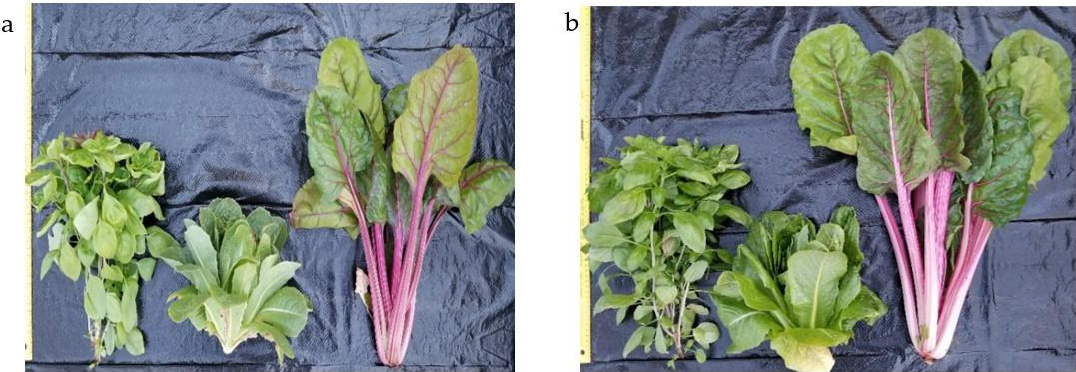
Figure 2. Basil ‘Cardinal’, lettuce ‘Auvona’, and Swiss chard ‘Magenta Sunset’ (left to right in both figures) grown in ( a ) ambient and ( b ) supplemented CO 2 condition 46 days after transplanting.